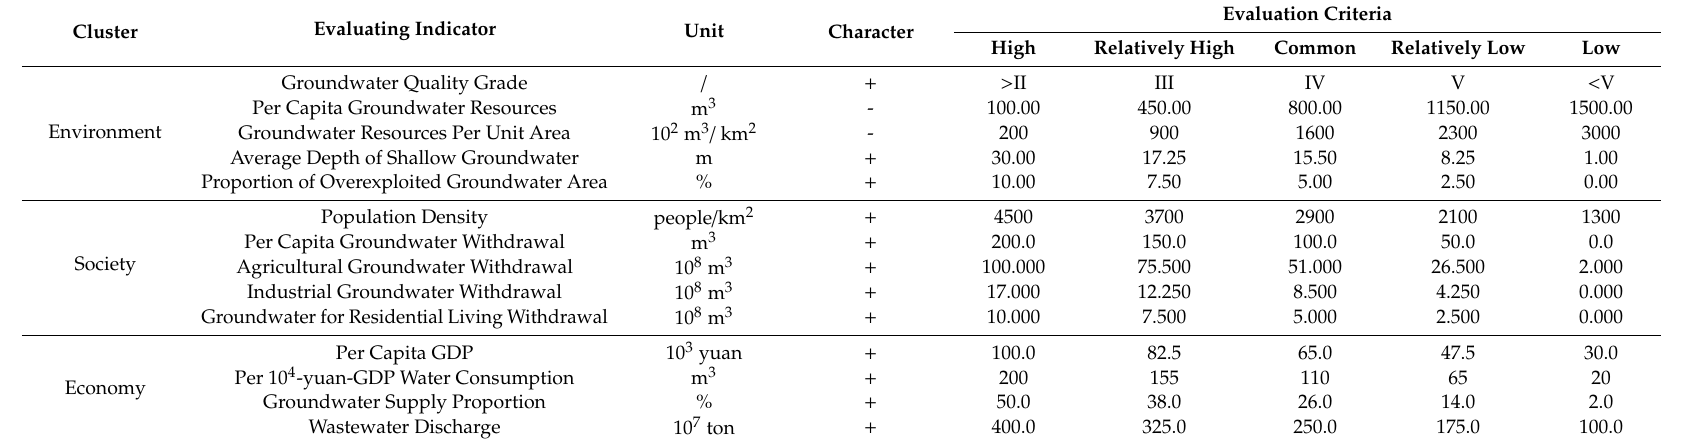
Table 4. Evaluation criteria of groundwater rights